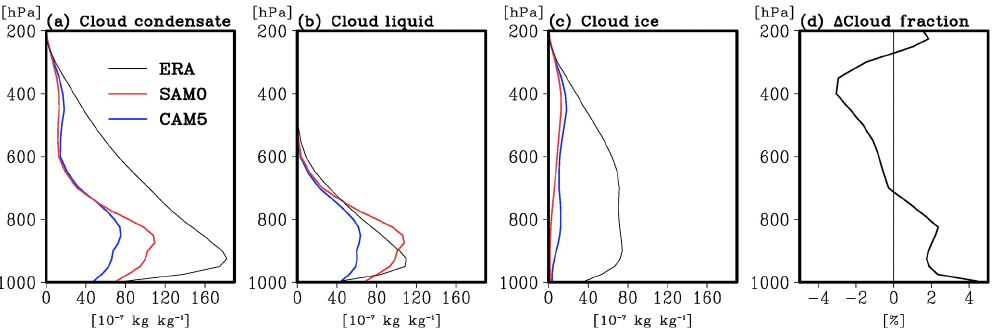
Figure 3. Annual-mean vertical profiles of grid-mean (a) cloud condensate mass (cloud liquid + cloud ice), (b) cloud liquid mass, and (c) cloud ice mass averaged over the Arctic from ERA-Interim reanalysis (ERA, black lines), SAM0 (red lines), and CAM5 (blue lines), and (d) the difference in cloud fraction between SAM0 and CAM5. ERA-Interim reanalysis was averaged from January 1979 to February 2015, and the model results are the means of AMIP simulation results for 36 years from January 1979 to February 2015.